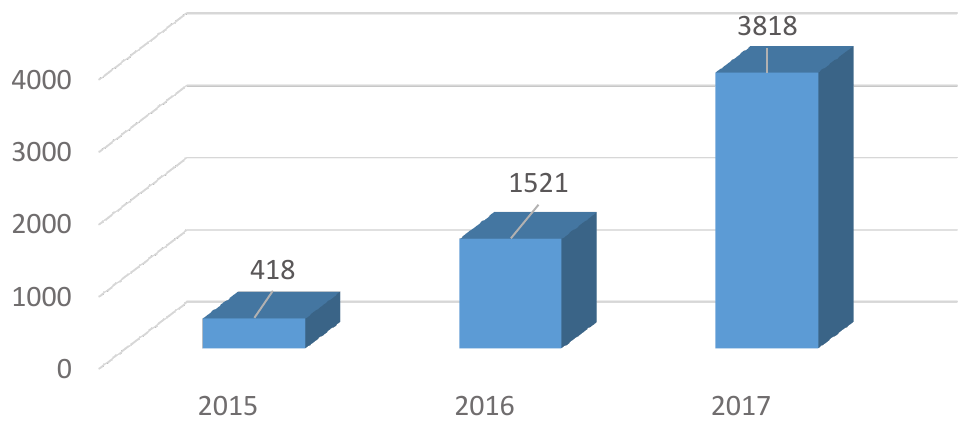
Figure 7. Number of electric